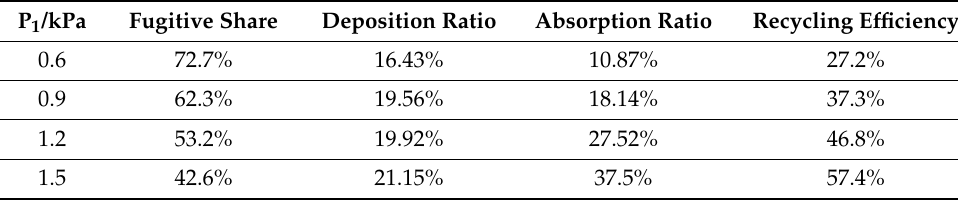
Table 5. Percentages of the escaping mist in different